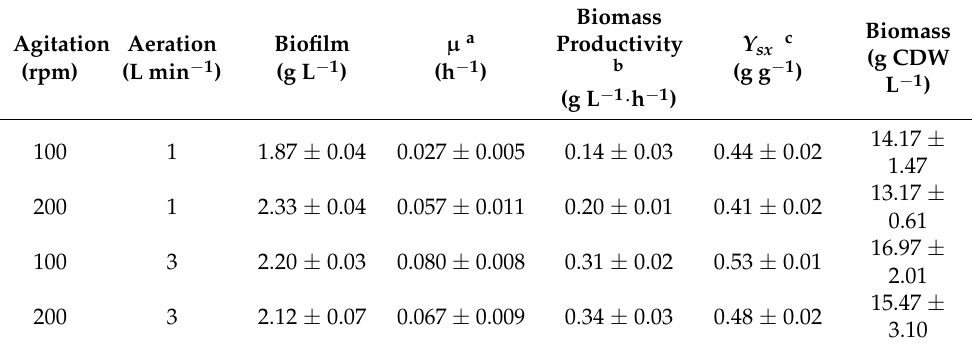
Table 1. Summary of results from the cultivation of C. maltosa SM4 in RBY. Mean values of triplicate experiments and standard deviations are